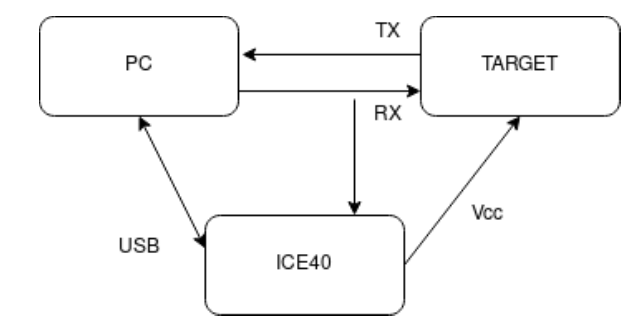
Figure 3: Schematic of the setup